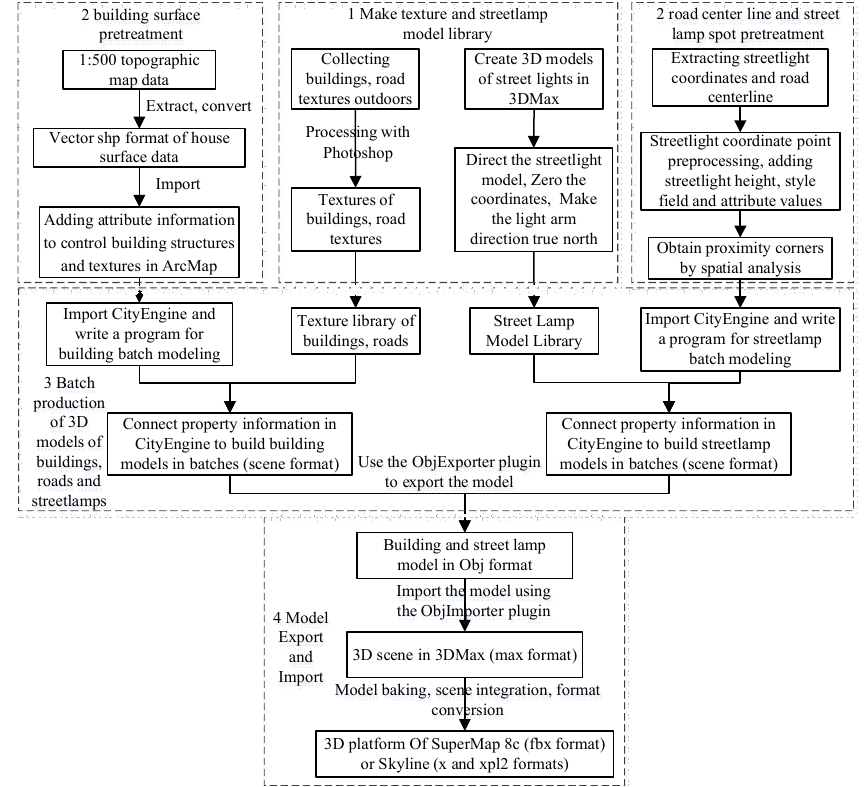
Figure 1. Overall process of 3D city batch modelling